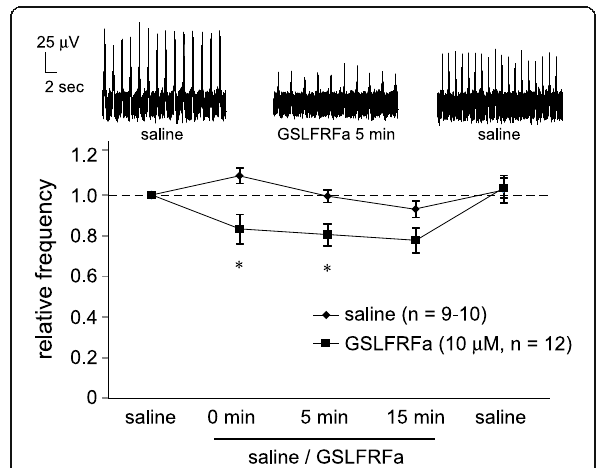
Fig. 6 GSLFRFamide reduces the oscillatory frequency of LFP in the PC. The upper traces indicate the representative waveforms of LFP for 20 s before the application, during the presence, and after the removal of 10 μ M GSLFRFa. * P < 0.05 vs. saline